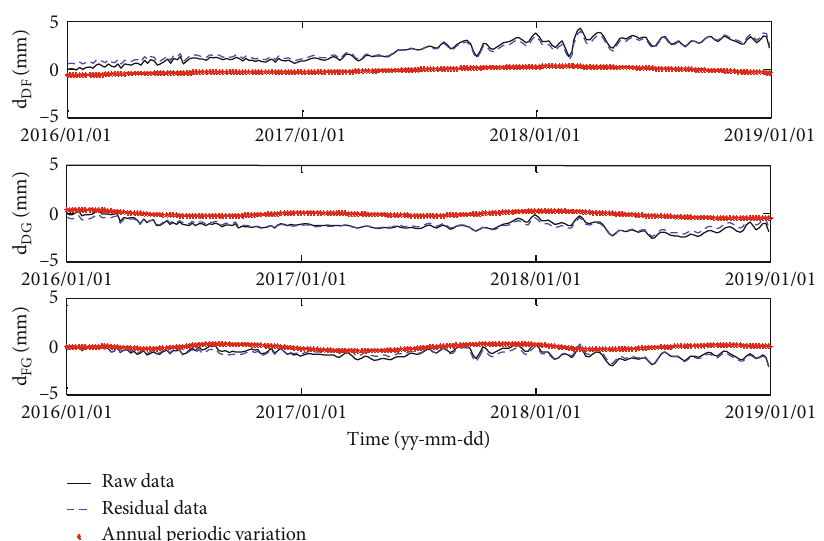
d d DF , (b) DF , and (c) FG from